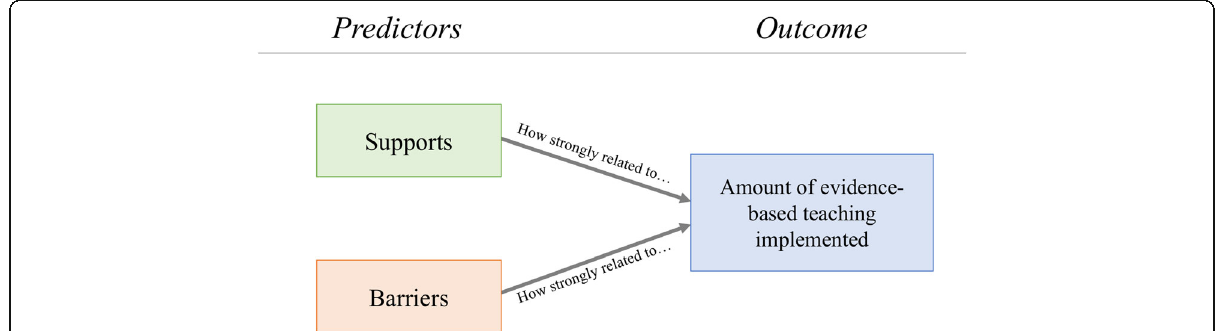
Fig. 1 The tested model of the relationship among faculty ’ s perception of supports and barriers to their adoption of EBT and the amount of EBT they report using in their